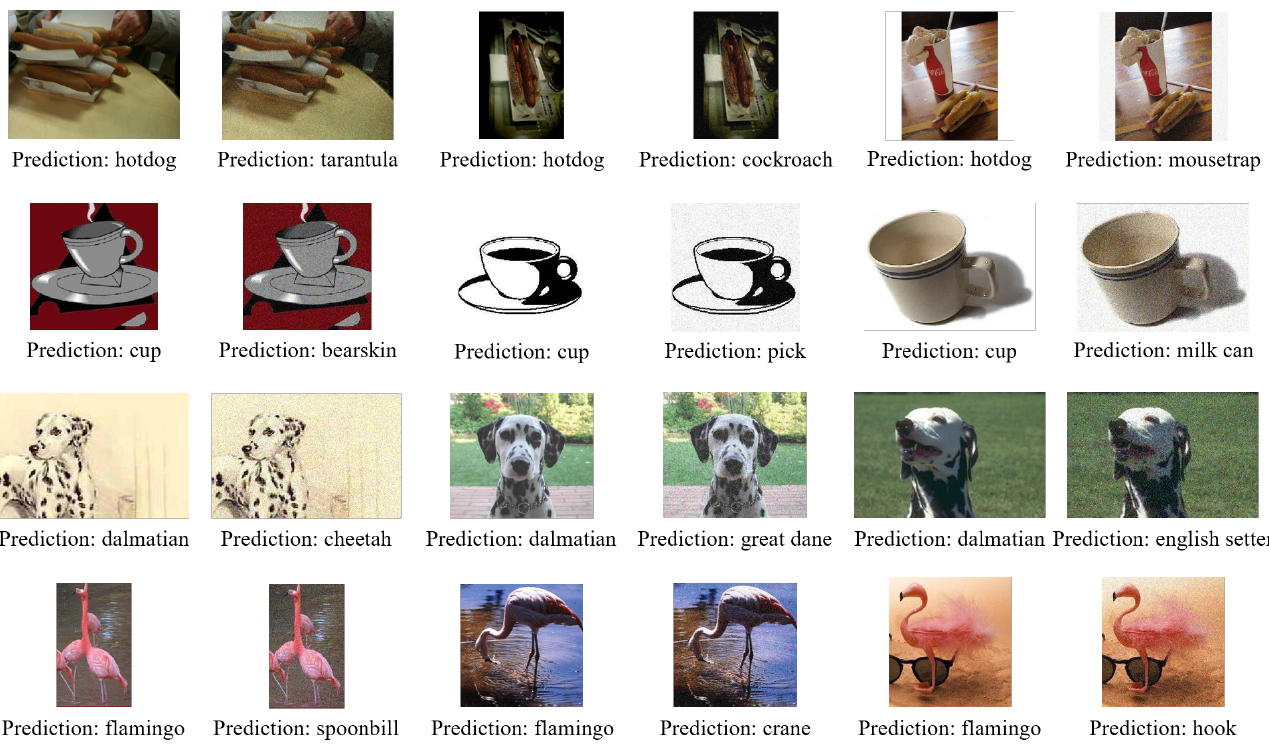
Figure 1. Comparison of classification results for original image and noisy